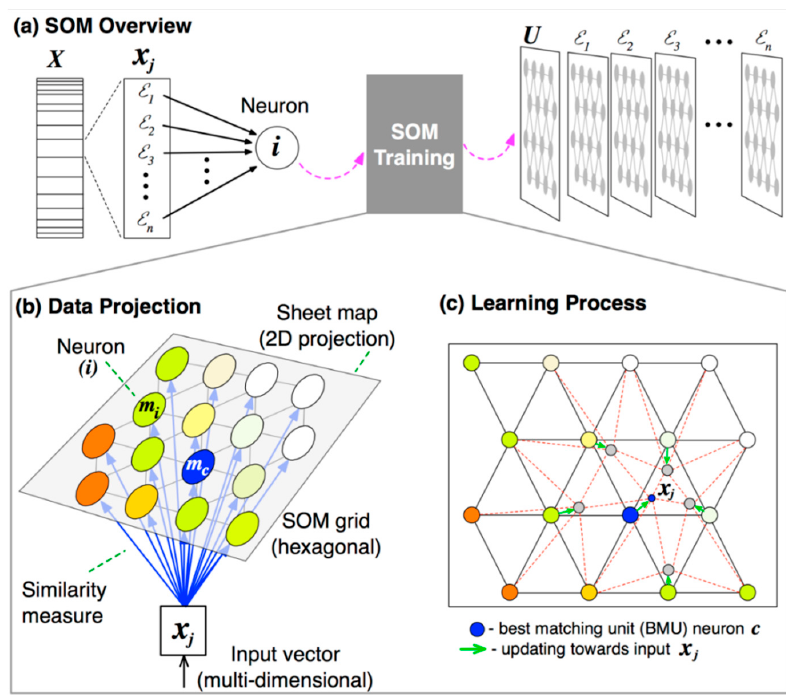
Figure 1. Schematic of basic sequential learning SOM applied to a dataset X : ( a ) two-dimensional SOM modelling a n-dimensional ( ξ 1 , ... , ξ n ) input data vector x j onto a hexagonal lattice sheet map of neurons with associated weight vectors such as m i in neuron i including the best-matching unit (BMU) c with associated weight vector m c ; ( b ) x j is projected to all the weight-initialized neurons in the grid to determine the BMU, in this case neuron c , to initiate the learning process; and ( c ) the weight vectors m i of the BMU and the neighboring neurons are updated to move the active neurons in the BMU neighborhood closer to x j in a recursive manner. SOM trains until neuron weight vectors asymptotically converge on all samples in X